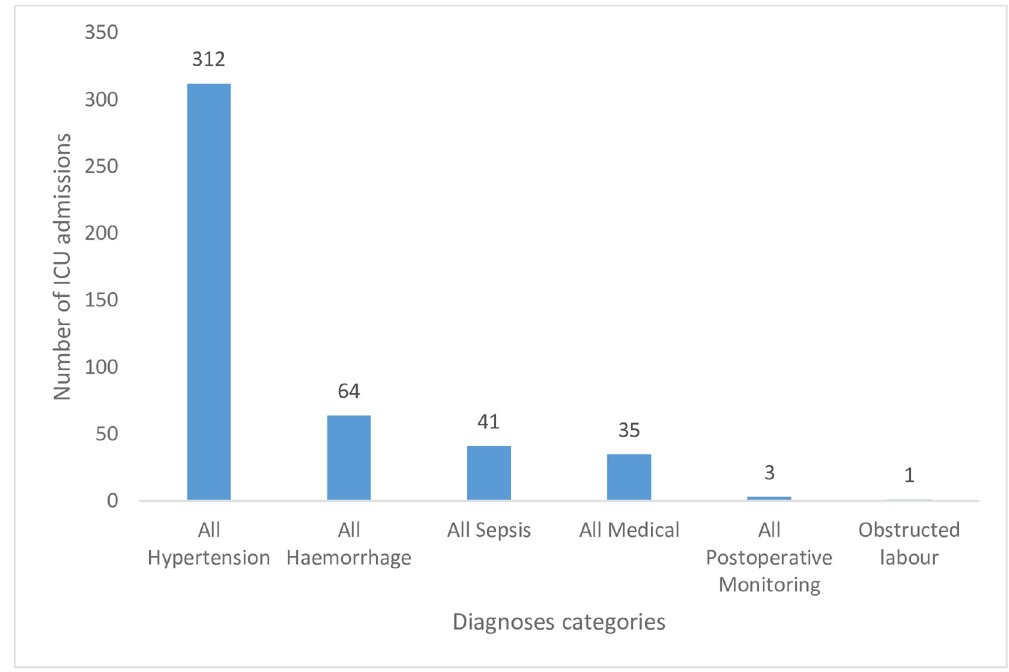
Fig 1. Indications and numbers of obstetric ICU admissions in Cape Coast Teaching Hospital from 2010 to 2019 (the sum exceeds 443 as there were individuals with multiple indications).